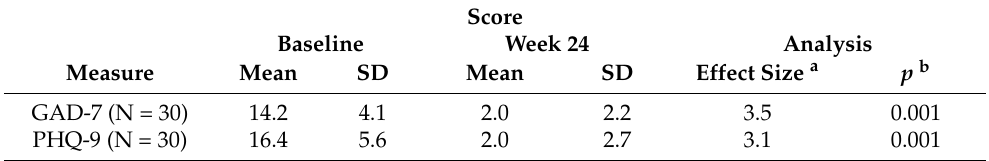
Table 3. Scores at Baseline and the Follow-up 12 Weeks after the End of Self-Attachment Intervention. Score Baseline Week 24 Analysis Measure Mean SD Mean SD Effect Size a p b GAD-7 (N = 30) 14.2